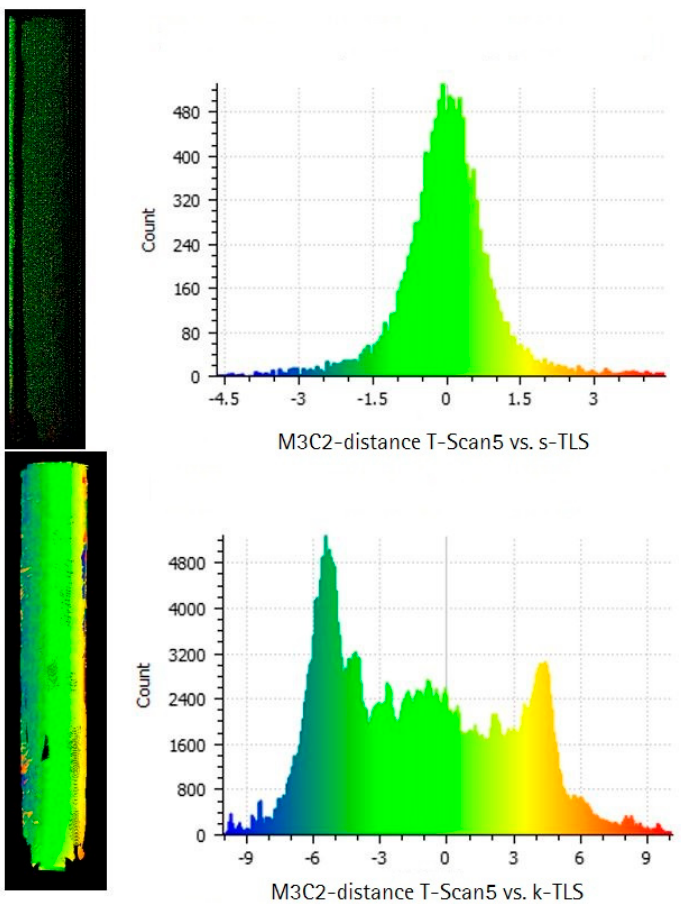
Figure 18. M3C2-distance in mm calculated with Cloud Compare for the cylinder, ( right ) difference point cloud and ( left ) histogram for T-Scan 5 compared to ( top ) s-TLS ( top ) and ( bottom ) k-TLS.